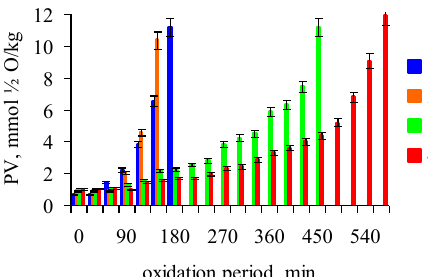
Fig. 2. Dynamics of accelerated oxidation: 1 – refined sunflower oil, 2 – refined sunflower oil with the addition of β-carotene 0.2 %; 3 – blended oil, 4 – blended oil with the addition of β-carotene 0.2